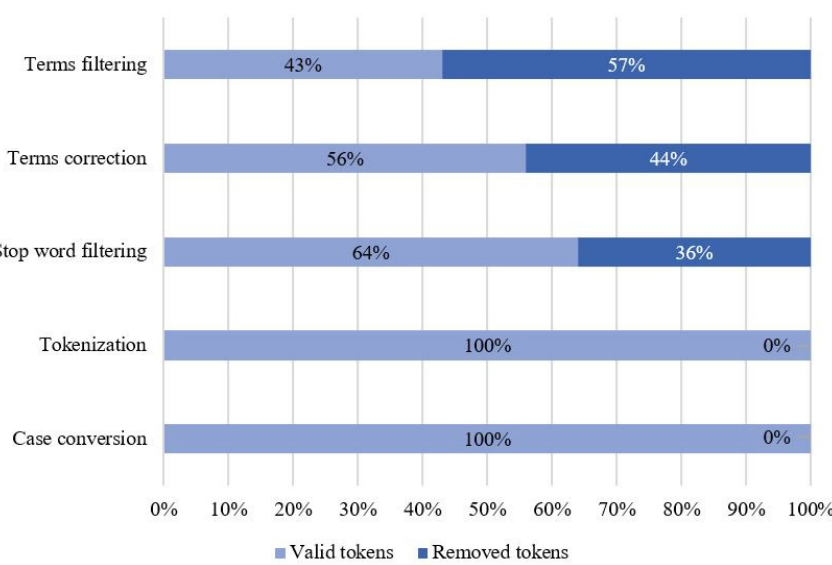
Figure 3. Valid tokens proportion after pre-processing.